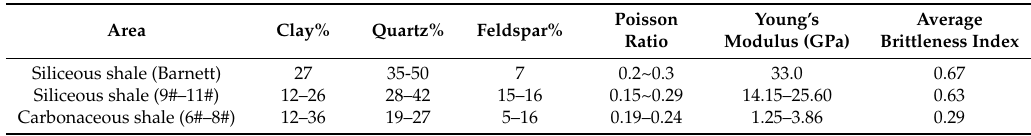
Table 5. Comparison of the minerals and mechanical parameters of Barnett shale with that of the marine shale in Niutitang Formation in northwestern Hunan. (Modified from [ 52 ]).